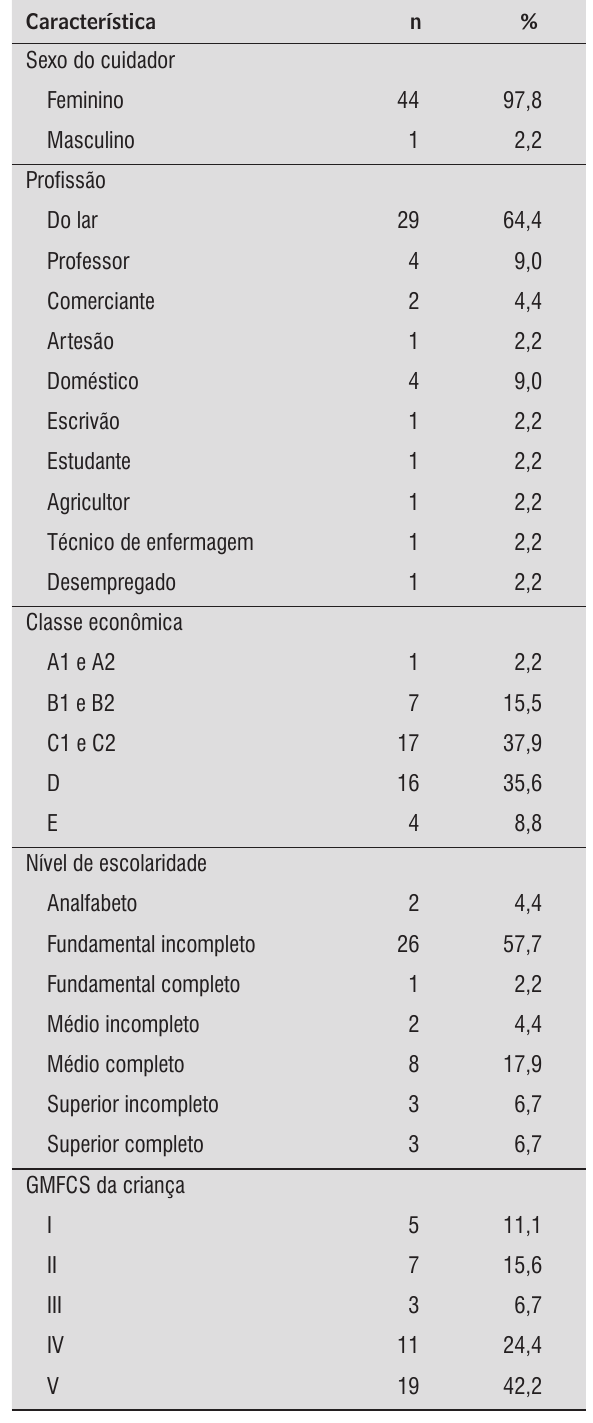
Legenda: GMFCS = Gross Motor Function Classi fi cation System. Fonte: Dados da